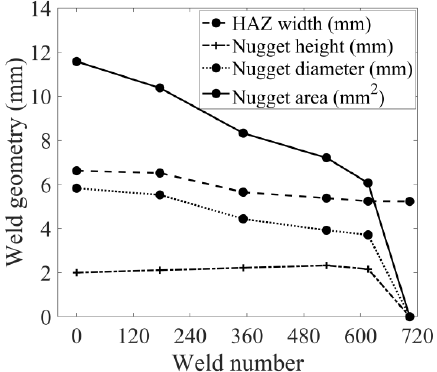
Figure 8. The geometries of the welded joints in the electrode failure process.